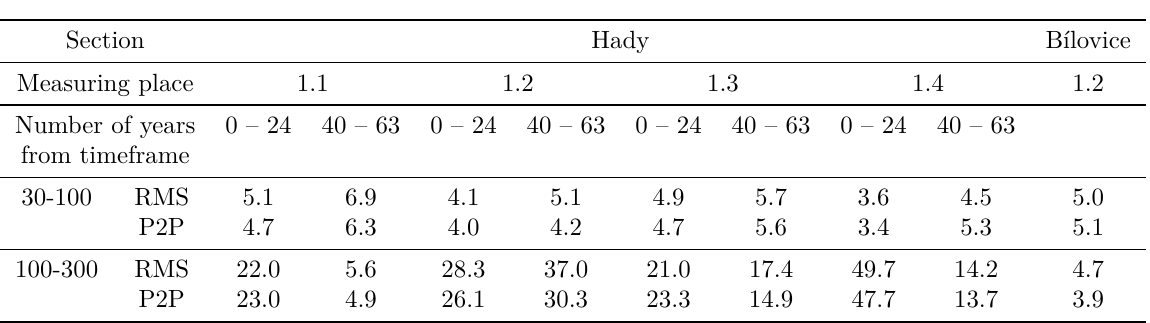
Table 3. Weighted cant deficiencies in curves for all recorded trains (not rounded).